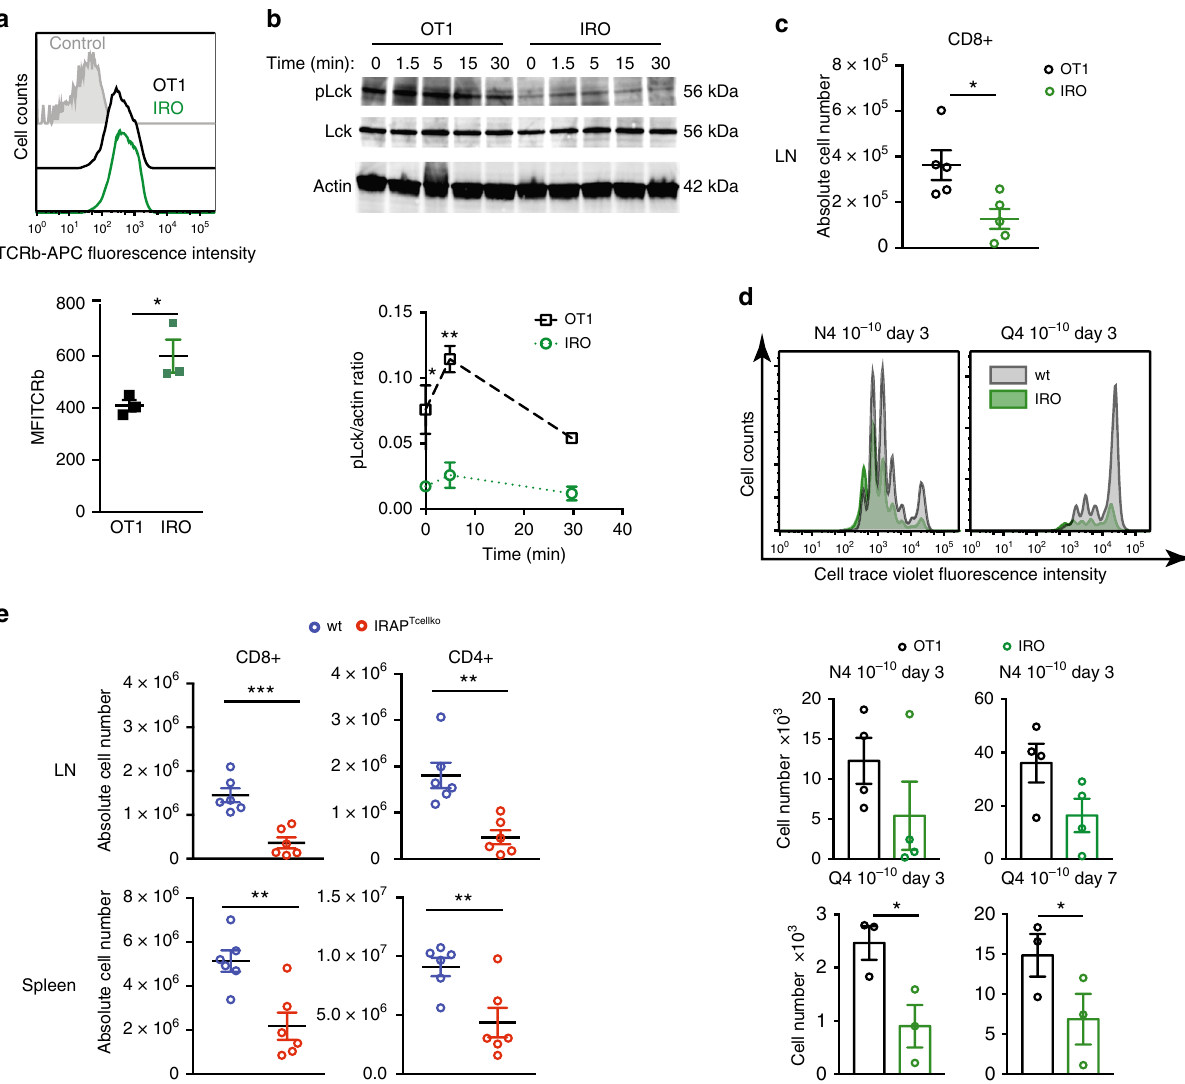
Fig. 6 IRAP-de fi cient mice have low numbers of peripheral T cells. a TCRb expression on the cell surface of effector OT1 or IRO T cells (culture day 7), measured by fl ow cytometry. Each symbol represents an individual experiment. Values represent mean ± SEM of three independent experiments, * p = 0.0468. b Immunoblot analysis of effector OT1 or IRO T cells after activation for the indicated time points by anti-CD3 ε /CD28 antibody. Values on quanti fi cation graphs represent mean ± SEM of pool of three independent experiments, * p = 0.0352, ** p = 0.0031. c CD8 + T-cell absolute number quanti fi cation in OT1 or IRO mouse lymph nodes by fl ow cytometry. Values represent mean ± SEM of fi ve mice from two independent experiments, * p = 0.0172. CD8 + cells are gated on CD45 + TCRb + live cells. d Quanti fi cation of number of OT1 and IRO T cells after activation by DC2.4 loaded with N4 or Q4 peptides. Values represent mean ± SEM of three or four independent experiments, Q4 day 3 * p = 0.017, Q4 day 7 * p = 0.011. Representative proliferation graphs at day 3 are shown. e CD8 + and CD4 + T-cell absolute number quanti fi cation in wt (IRAP loxlox ) or IRAP Tcellko mouse lymph nodes or spleen by fl ow cytometry. CD8 + and CD4 + cells are gated on CD45 + TCRb + live cells. Values represent mean ± SEM of six mice from two independent experiments, LN CD8 + *** p = 0.0003, CD4 + ** p = 0.0017; spleen CD8 + ** p = 0.0037, CD4 + ** p = 0.0096. All p -values ( a , b , c , d , e ) were calculated with two-tailed unpaired t tests. For additional information, see Supplementary Figs. 4, 5, 6 and